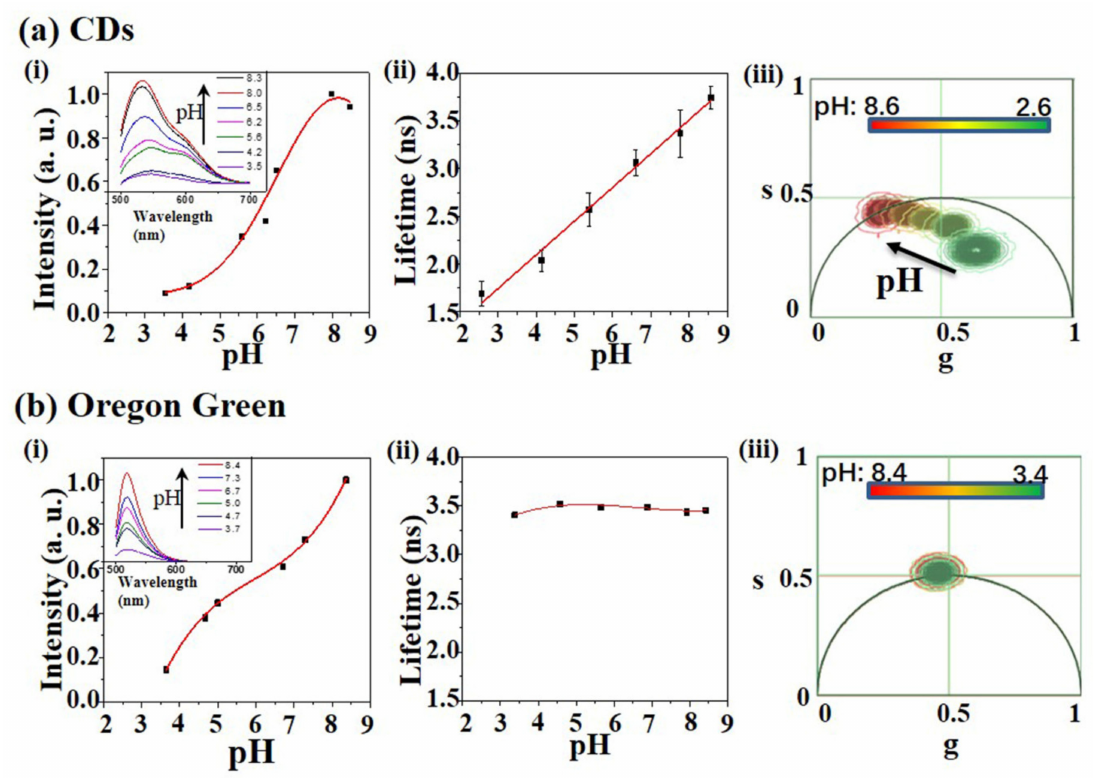
Figure 1. Comparison of the fluorescence characteristics of ( a ) CDs and ( b ) commercial pH sensor Oregon Green in di ff erent pH environments. (i) Fluorescence intensity changes with pH values (the error bar is very small in this case and the inset is the fluorescence spectra), (ii) fluorescence lifetime changes with pH values, and (iii) phasor analysis of FLIM